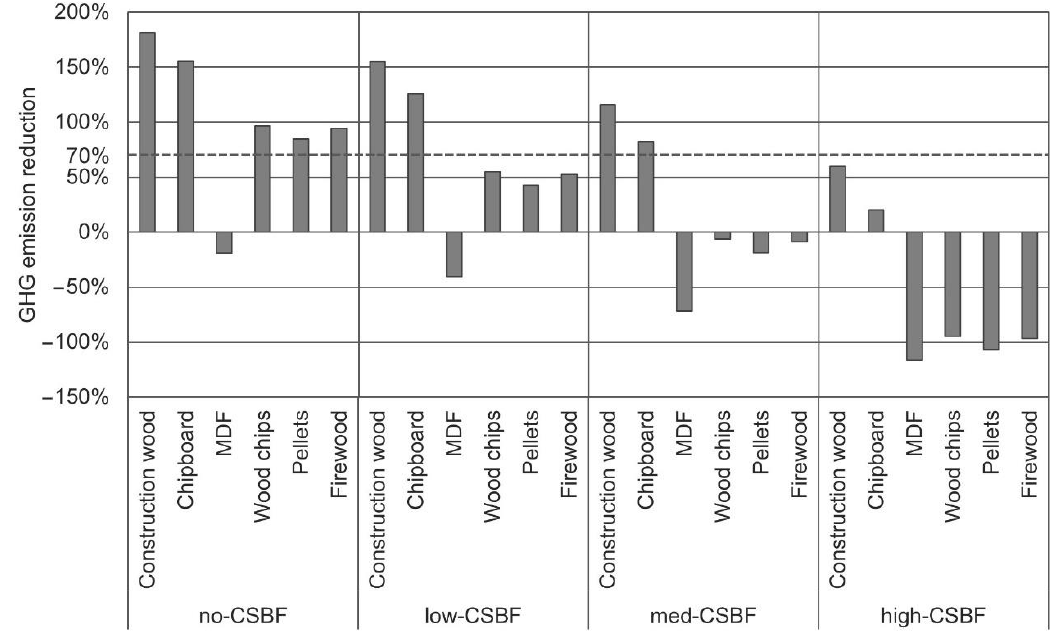
Figure 3. Greenhouse gas emission reduction (ER) of wood products in relation to non-wood products in different carbon storage balance scenarios in forests. According to RED II [27], ER shall be at least 70% for heating production from wood used in installations starting in 2021. MDF = medium-density fiberboard, CSBF = carbon storage balance in forests. See explanation of the scenarios no-CSBF, low-CSBF, med-CSBF and high-CSBF in Table 3.